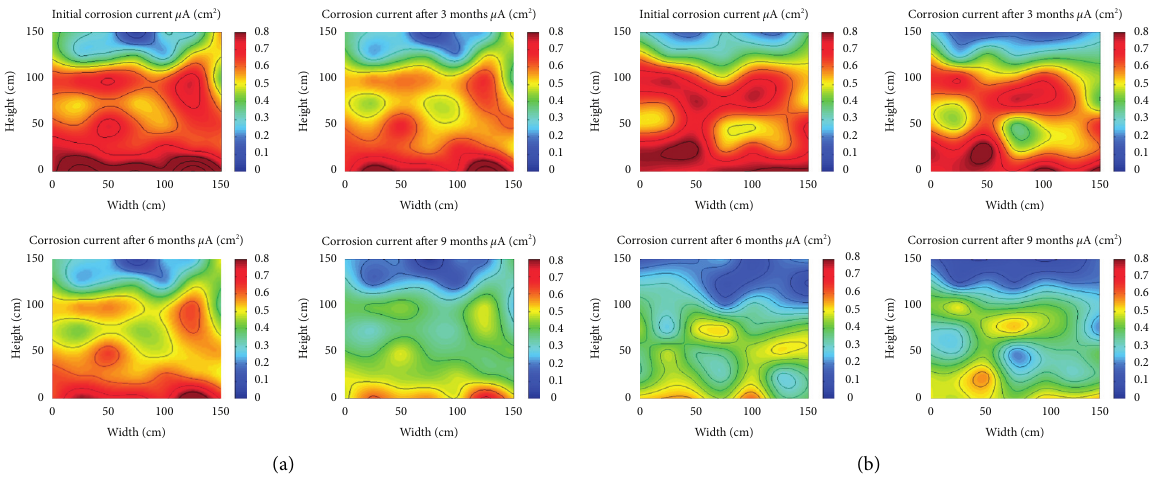
Figure 12: Corrosion current of rebar in existing concrete. (a) Corrosion current of brushing repair. (b) Corrosion current of composite